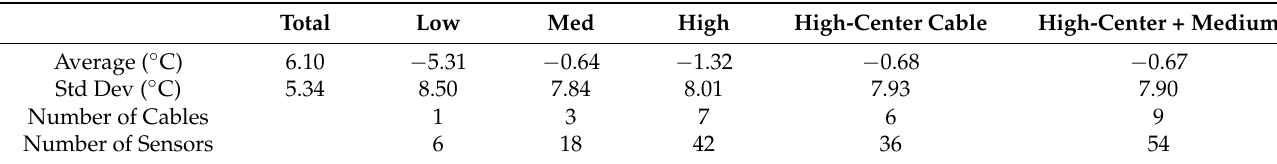
Table 1. The average temperatures and standard deviations reported for each of the three cable configurations defined in Figure 2, as well as the high sensor distribution without the center cable, and that distribution plus the medium, versus the average temperature calculated for the numerical solution (total) for a one-year controlled aeration simulation of 1346 MT of maize beginning 1 October, 2014. The fan was turned on whenever ambient air was cooler than the sensor in the center of the grain mass and the average was above 0 ◦